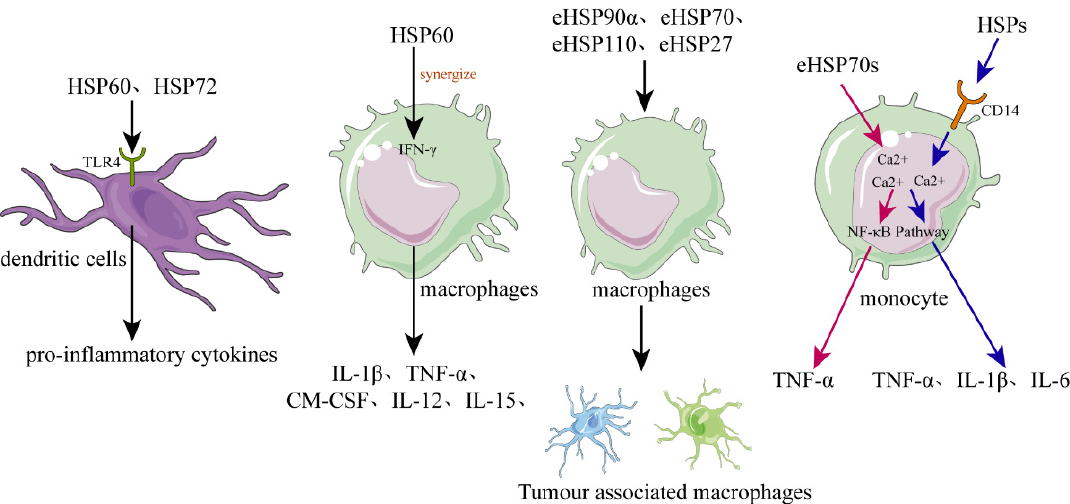
Figure 2. The role of HSPs in regulating inflammation and immune responses. In dendritic cells (DCs), recombinant human HSPs, such as HSP60 and HSP72, can promote their maturation and can activate them to secrete the proinflammatory cytokines. Released or recombinant eHSPs can stimu-